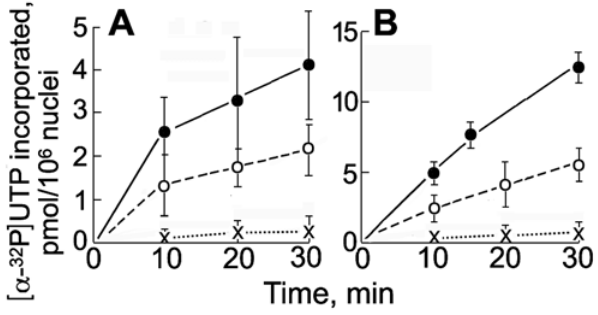
Figure 5. Run-on incorporation of [ a - 32 P]UTP into nascent RNA in nuclei isolated and incubated in polymer solution in 100 m M K-Hepes. K + was added to the medium to , 1 mM to neutralise the nucleotide triphosphate RNA precursors. (A) nuclei isolated and incubated in 50% Ficoll; data points and error bars show means 6 SEM (n=5) for 30 min, and means and ranges (n=2) for other points. (B) nuclei isolated and incubated in 12% 8 kDa PEG; data points and error bars show means 6 SEM (n=9 for 30 min, n=3 for other points). Full lines show incorporation in the complete system, dashed lines with addition of a -amanitin (200 m g/ml) to inhibit RNA pol II, and dotted lines in the absence of polymer.